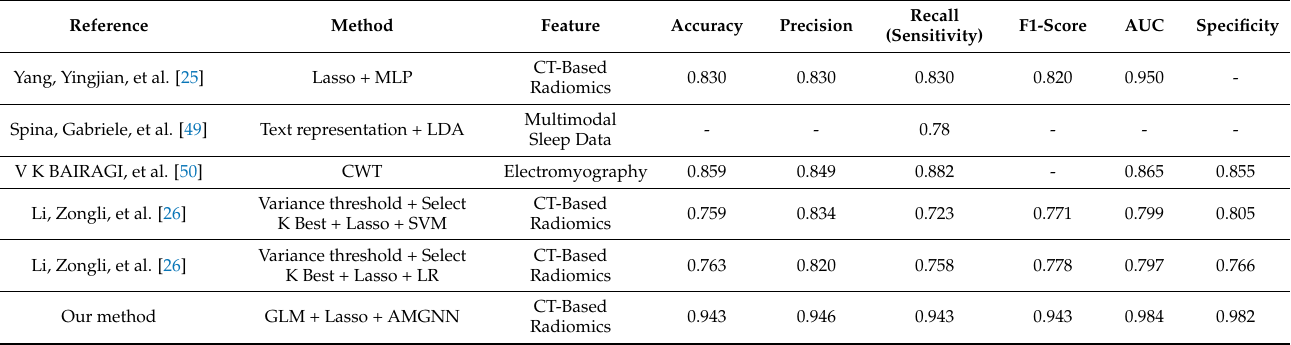
Table 11. Comparison of the results of our proposed method with other previous